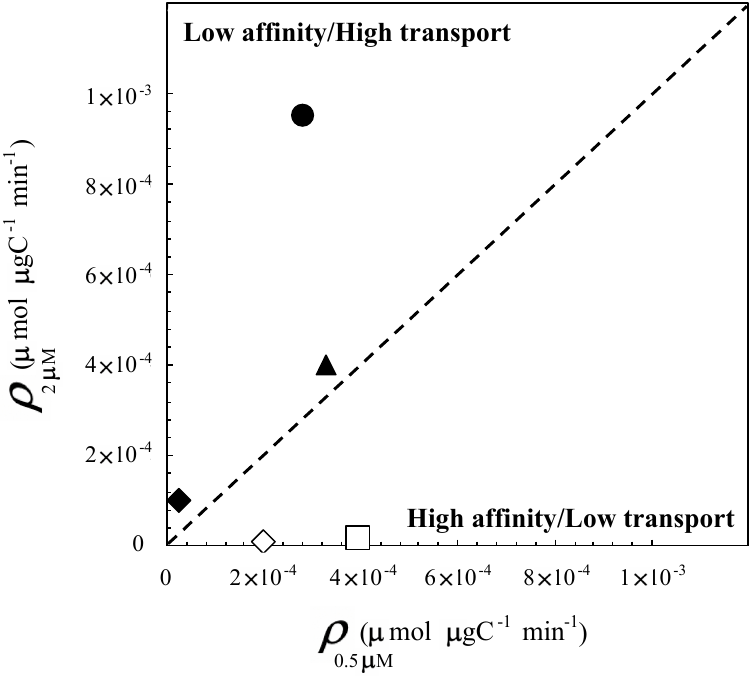
Figure 6. Surge uptake rates after a pulse of 2 µ M ( ρ 2 µ M ; µ mol µ gC − 1 min − 1 ) vs. surge uptake rates after a pulse of 0.5 µ M ( ρ 0.5 µ M ; µ mol µ gC − 1 min − 1 ). The closed symbol are the surge uptake rates measured at stations characterized by high turbulence levels ε (i.e., ε > 10 − 5 m 2 s − 3 ); S-May (diamond), S-July (triangle) and N-July (circle). The open symbols are the surge uptake rates measured at stations characterized by low turbulence levels (i.e., ε < 10 − 5 m 2 s − 3 ); N-May (diamond) and S-April (square). The size of the symbol represents the 99% confidence intervals of triplicated surge uptake rates.